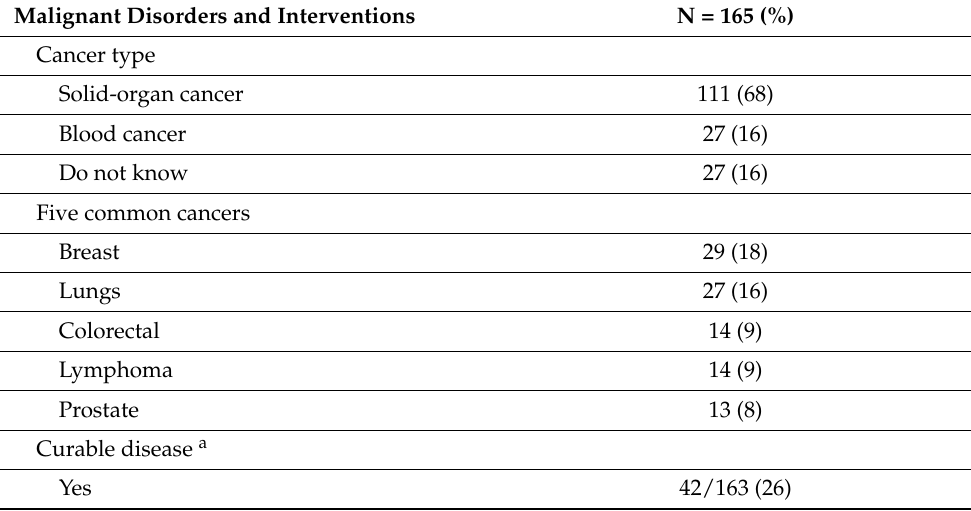
Table 2. Types of malignant disorders and